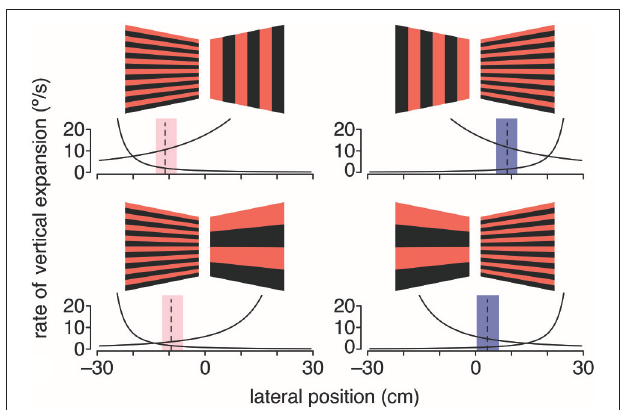
FIGURE 4 | Hummingbirds appear to use expansion cues for lateral course control. Black and red gratings depict the stationary visual patterns displayed on the left and right walls of the tunnel. Dashed lines are the average lateral positions, and shaded regions are the average extremes for birds at the halfway point through the tunnel. Black lines indicate the rate of vertical expansion for a bird moving laterally at 0.1 m/s, which is the typical maximum lateral flight speed. Adapted with permission from Dakin et al.